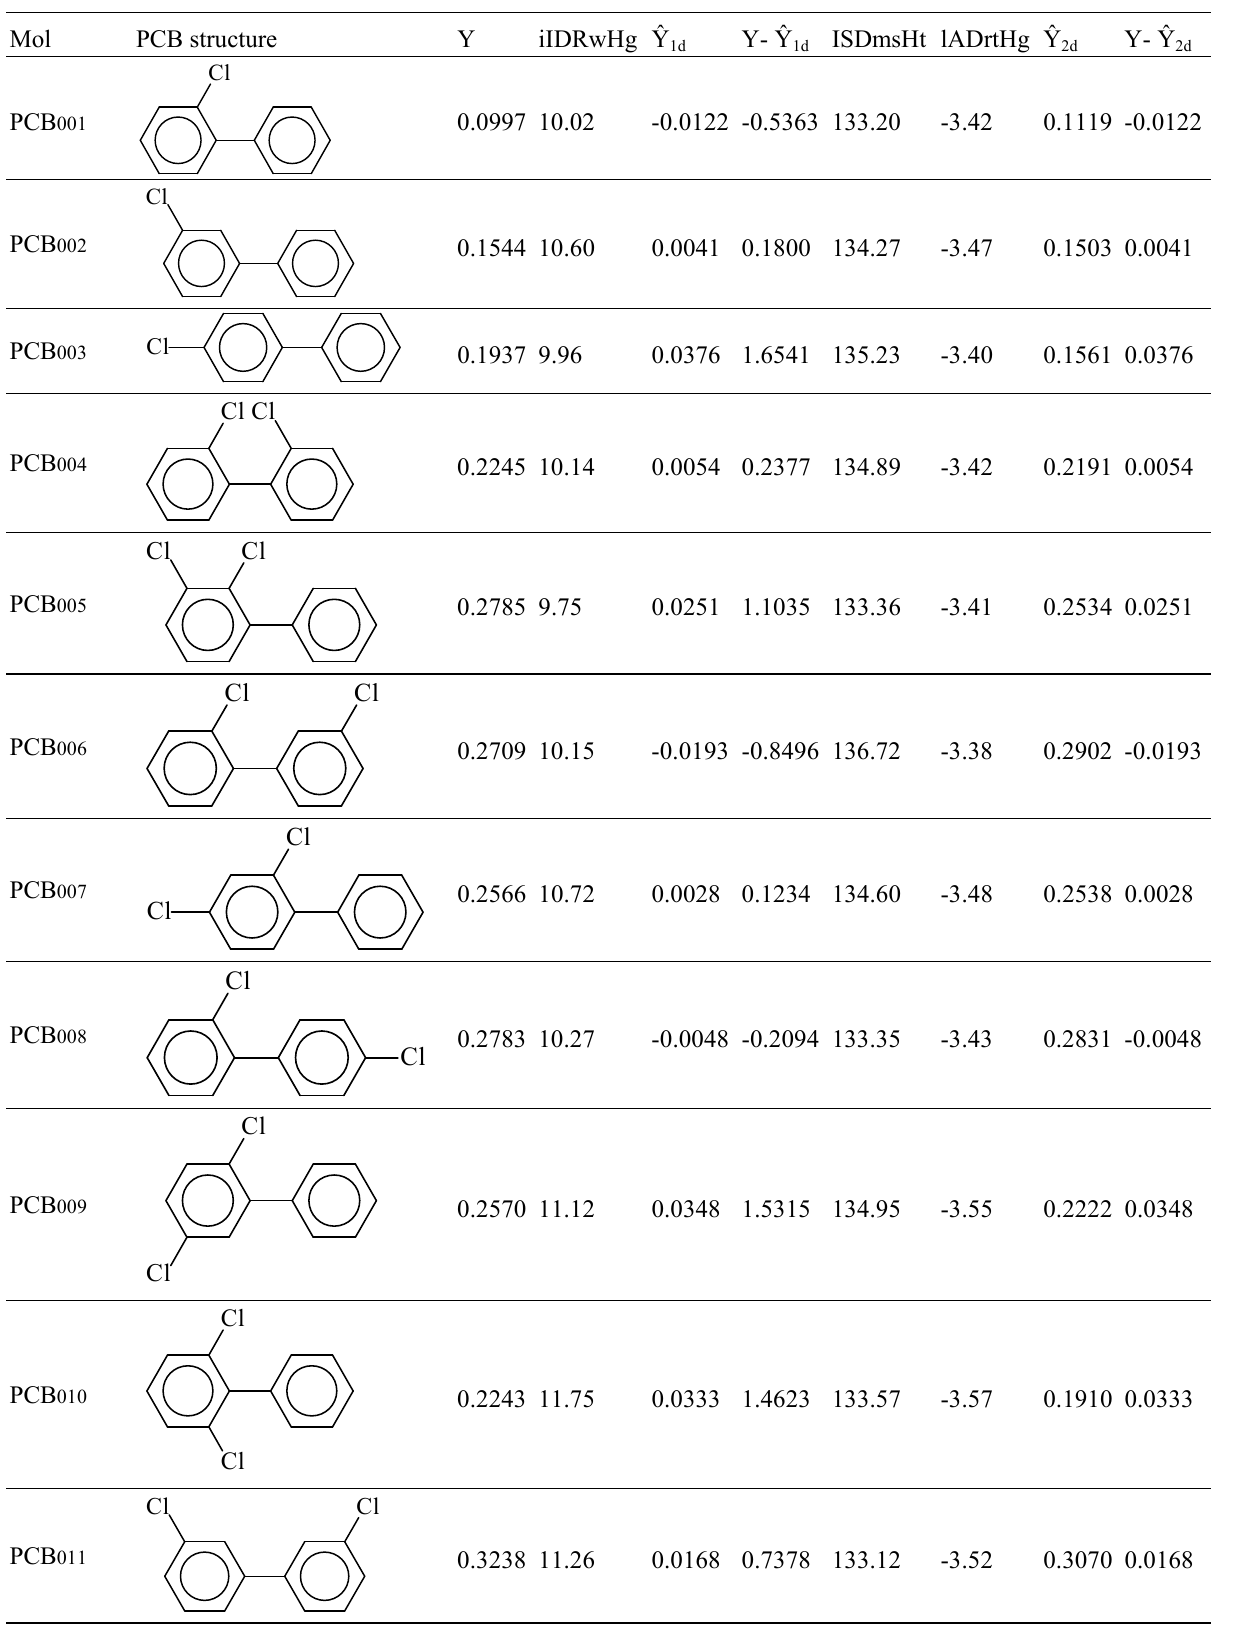
Table 1. PCBs MDF descriptors, estimated and residuals obtained by